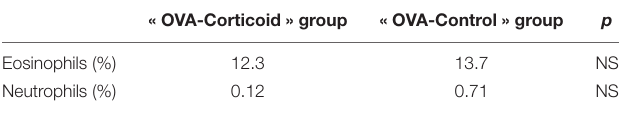
Mann-Whitney U-test for comparison between groups.